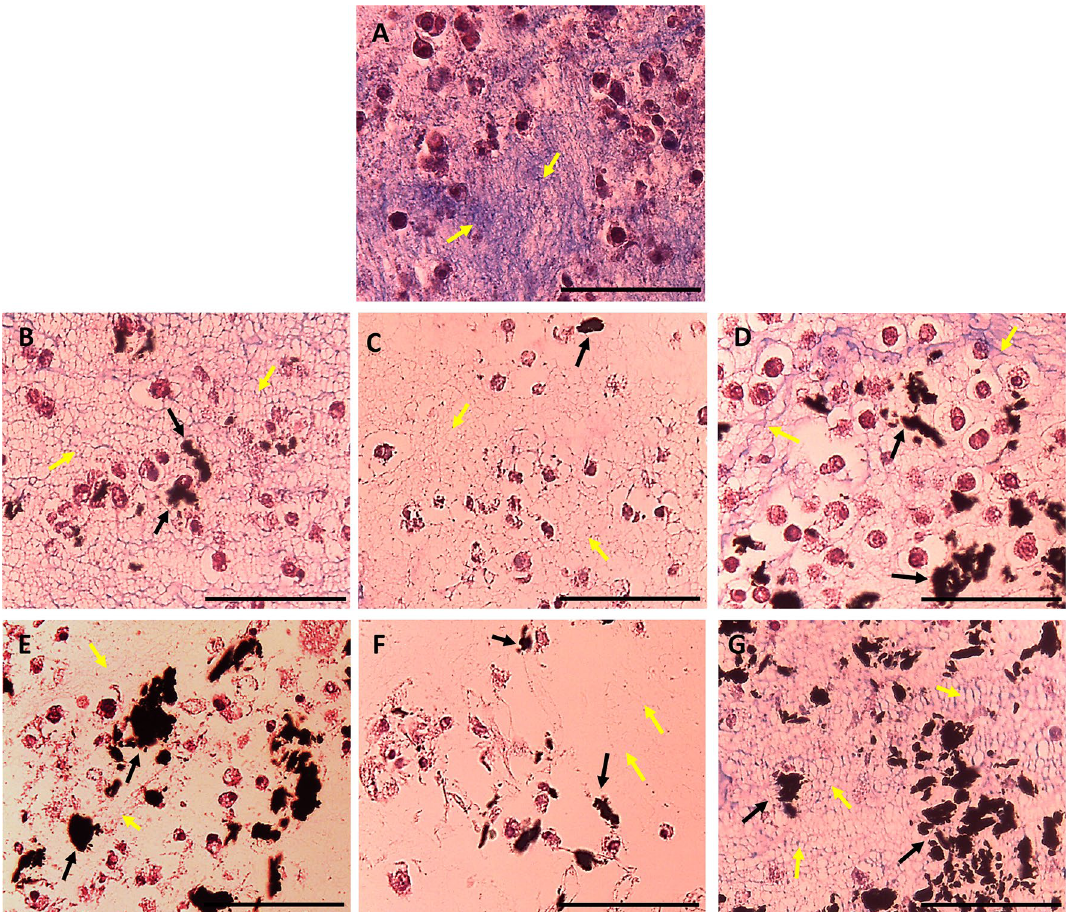
Figure 10. Microscopic images of collagen-based ECTs containing different concentrations of SWCNTs-Py-OH or SWCNT-Py-COOH. The tissue sections were stained with Masson’s trichrome stain and examined with a light compound microscope. ( A ) Control ECT; ( B ) 0.025% SWCNTs-Py-OH; ( C ) 0.050% SWCNTs-Py-OH; ( D ) 0.100% SWCNTs-Py-OH; ( E ) 0.025% SWCNTs-Py-COOH; ( F ) 0.050% SWCNTs-Py-COOH; ( G ) 0.100% SWCNTs-Py-COOH. Scale bar 100